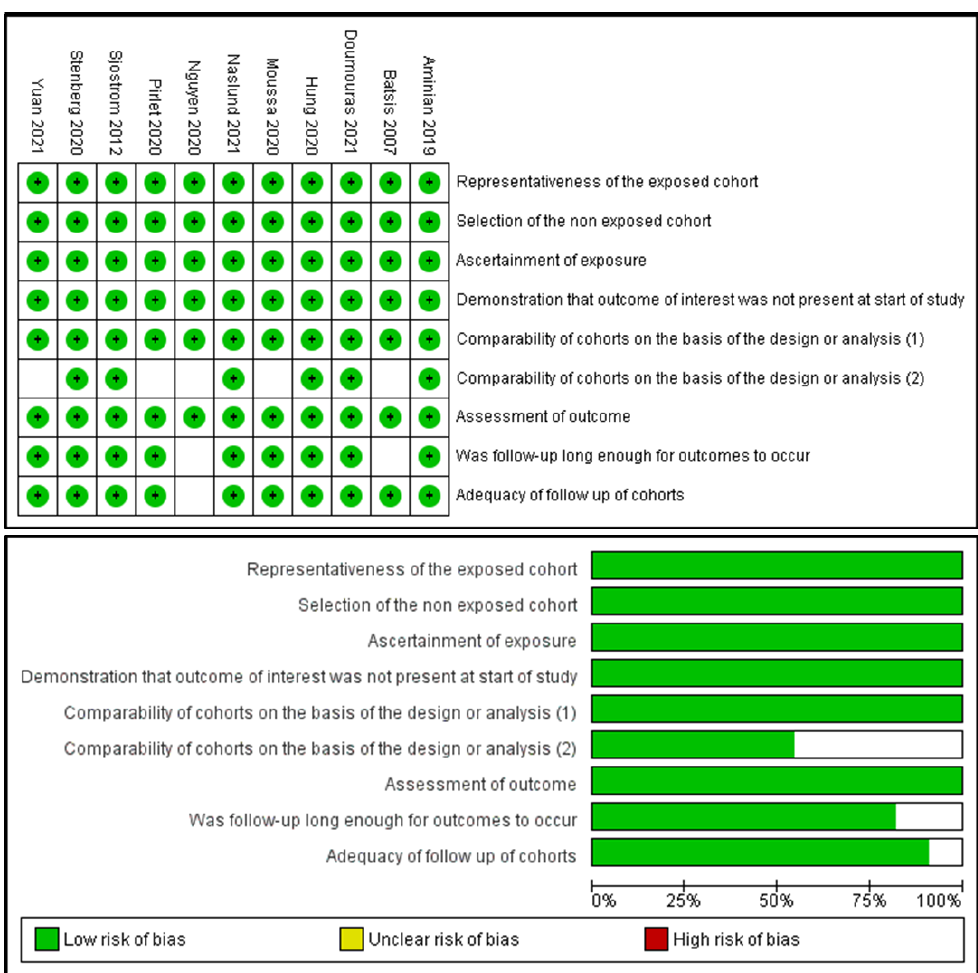
Figure 3. Risk of bias assessment with the Newcastle – Ottawa Scale (NOS).